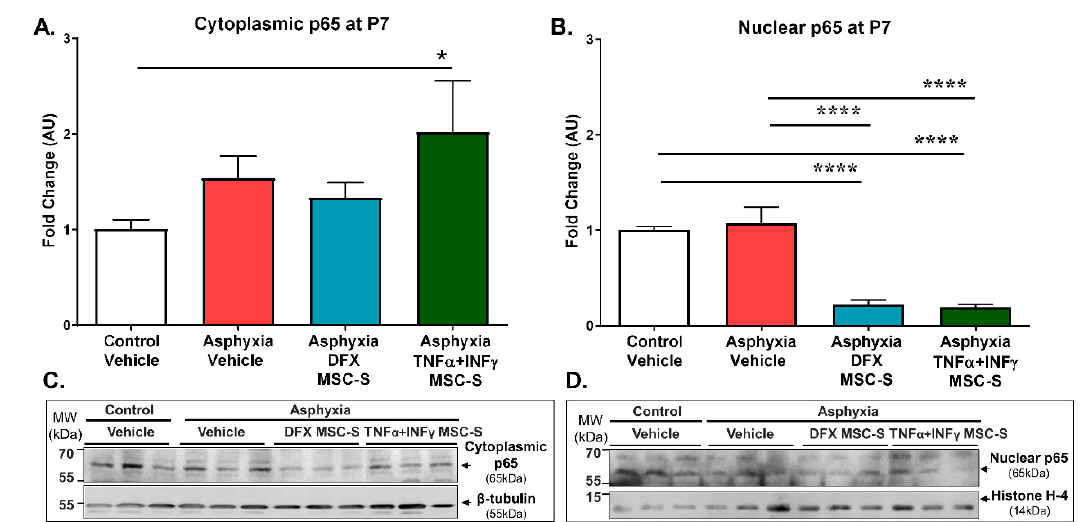
Figure 4. E ff ect of intranasal administration of DFX- or TNF- α + IFN- γ -MSC-S on cytoplasmic and nuclear p65 protein levels determined in hippocampus of PA-exposed rats at P7. ( A ) Cytoplasmic and ( B ). Nuclear p65 protein levels evaluated by Western blot at P7 in control (white bar) and asphyxia-exposed rats (red bar), intranasally treated with vehicle- or DFX-MSC-S (cyan bar) or TNF- α +IFN- γ -MSC-S (green bar). β -tubulin and histone H-4 were used as normalizers for cytoplasmic and nuclear extracts, respectively. Data are presented as ratios of protein levels/normalizer levels, relative to control levels. Representative Western blot images are shown in ( C ). and ( D ). Data represent means ± SEM. ( A ) Cytoplasmic p65 protein levels: An increased cytoplasmic p65 level was observed in PA treated with TNF- α +IFN- γ -MSC-S (green bar), compared to vehicle-treated control rats (CS, white